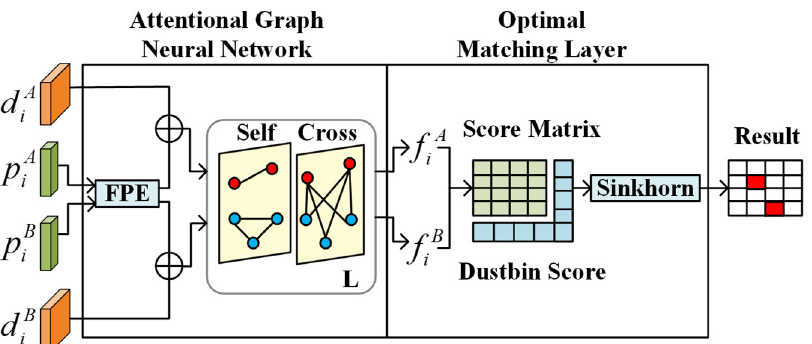
Figure 2. The architecture of SuperGlue. SuperGlue uses a keypoint encoder, which is also called a feature point encoder (FPE), to fuse contextual cues (keypoint position p and descriptor d ) and then uses alternating self- and cross-attention layers (repeated L times) to obtain matching descriptors f .